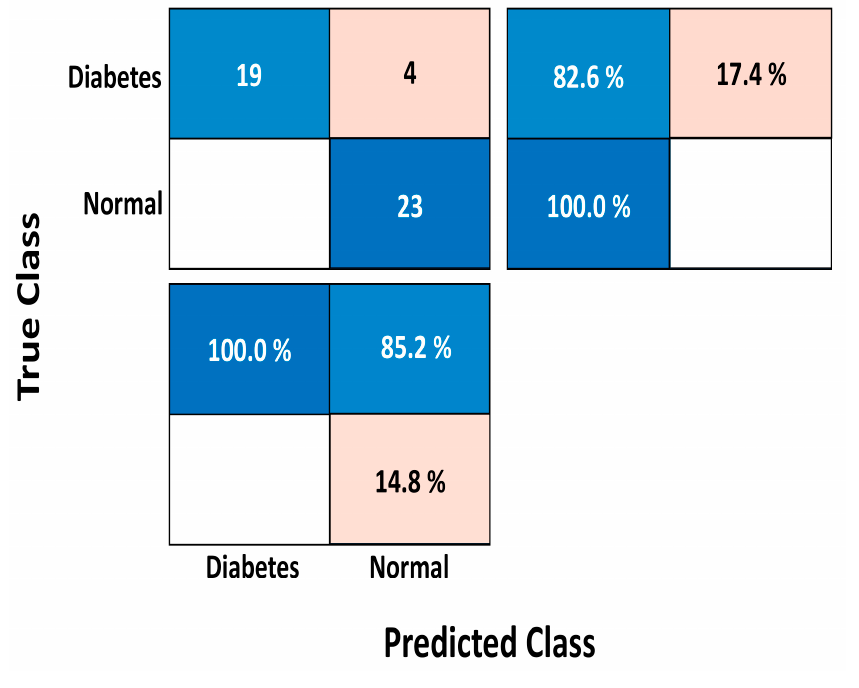
Table 7. Classification performance of super vector machine